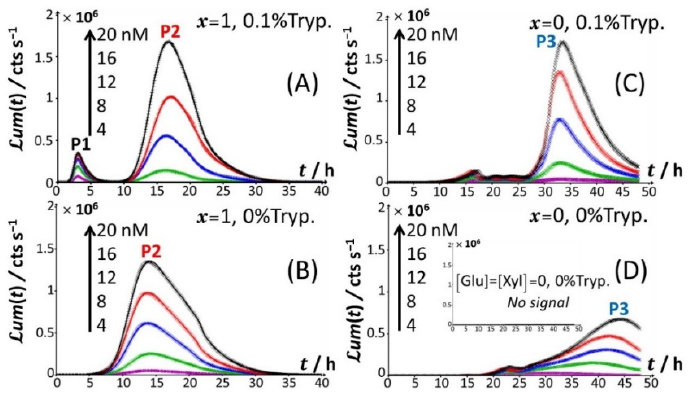
Figure 1. Time-dependent bioluminescence ( L um ( t ) in counts per second) produced by Cd-responsive whole-cell biosensors in the presence of glucose and the absence of xylose ( x = 1) and vice versa ( x = 0), with or without the supplementation of 0.1% tryptone (abbreviated as Tryp.), as specified in panels ( A – D ). Measurements are reported for different total Cd concentrations in the range of 0 – 20 nM (indicated). t = 0 corresponds to the introduction of Cd in solution and the start of bioluminescence measurement. Signals were corrected by point-by-point subtraction of the corresponding cell response measured in 0 nM Cd